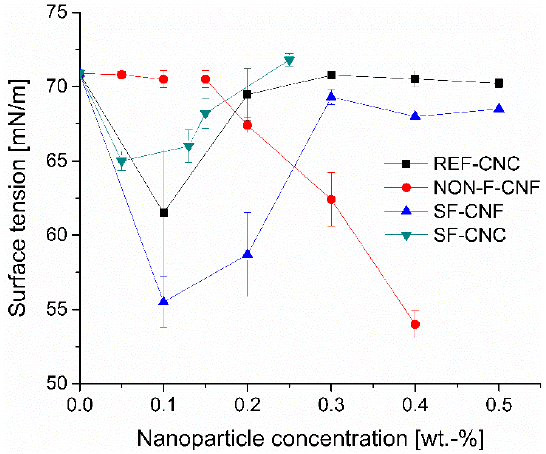
Figure 8. The surface tension of water with increasing nanoparticle concentrations.